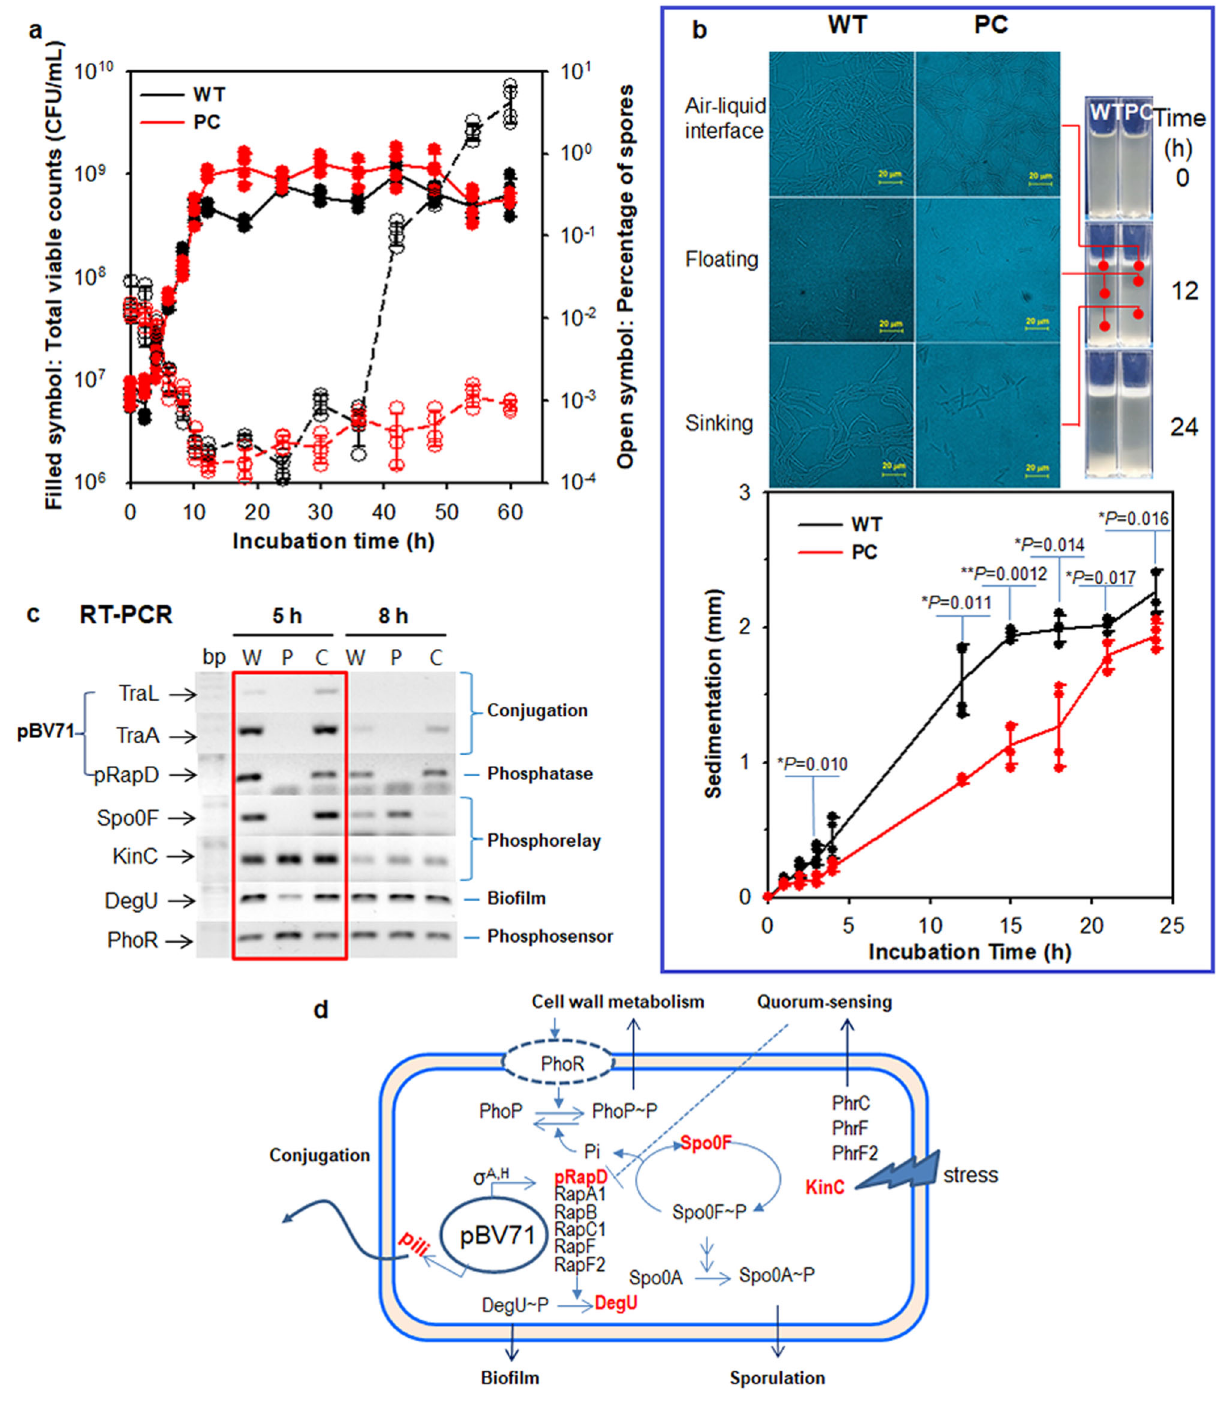
Fig. 6 Growth characteristics and plasmid-associated gene expression patterns in non-mucoid and mucoid phenotypes of strain GH1-13 with or without pBV71. a Growth curves (solid lines) and percentage of spores (red dotted lines) of WT and PC cells during cultivation in tryptic soy broth at 25 °C with shaking (180 rpm). b Variation in cell density and morphology in air – liquid interface, fl oating, and sinking cells during static culture of WT and PC cells in acryl cuvettes (10 × 10 × 40 mm) installed with transparency polypropylene slips. The variation in crystal violet-stained cell densities with depth along the slips is shown in the left photos. Statistically signi fi cant differences between sedimentation rates of cells were tested by two-tailed t -tests with P -values of <0.05. n = 4 independent experiments (Supplementary Data 3). The mean and standard deviation (error bar) are plotted for all graphs. c Semi- quantitative PCR results for three plasmid gene products (TraL, TraA, and pRapD) and associated response regulatory gene products (Spo0F, KinC, DegU, and PhoR) in WT, PC, and COM cells at 5 h (early exponential phase) and 8 h (late-exponential phase). The early response to transcription of the plasmid genes is highlighted in the red box. d Schematic illustration showing the impact of pBV71 on conjugation and bio fi lm formation of host cells in a quorum- sensing manner via a crosstalk between pRapD and chromosomal Rap-Phr